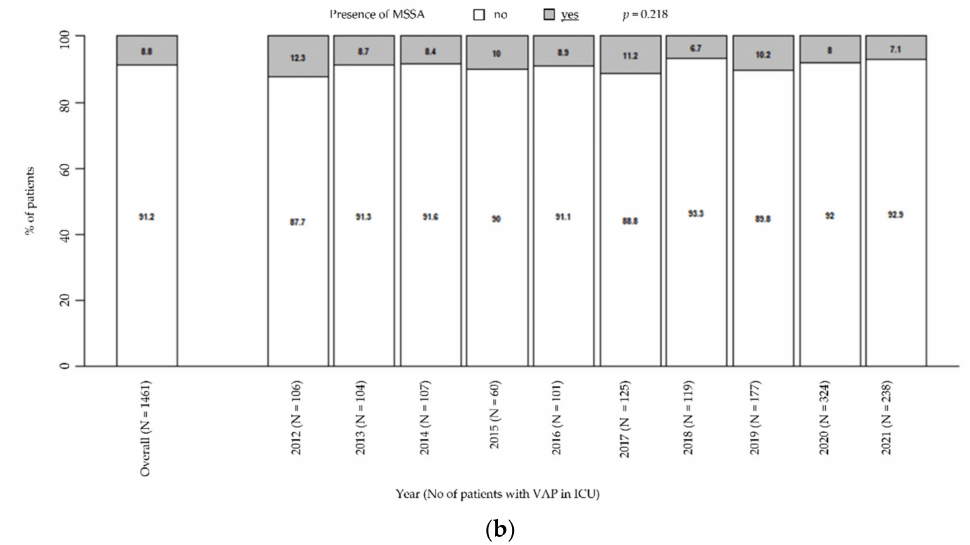
Figure 2. Prevalence of MRSA in patients with VAP in ICU ( a ). Prevalence of MSSA in patients with VAP in ICU ( b ). p -value by Chi-squared test for trend in proportions. ICU: intensive care unit. MRSA: methicillin-resistant Staphylococcus aureus . MSSA: methicillin-susceptible Staphylococcus aureus . VAP: ventilator-associated